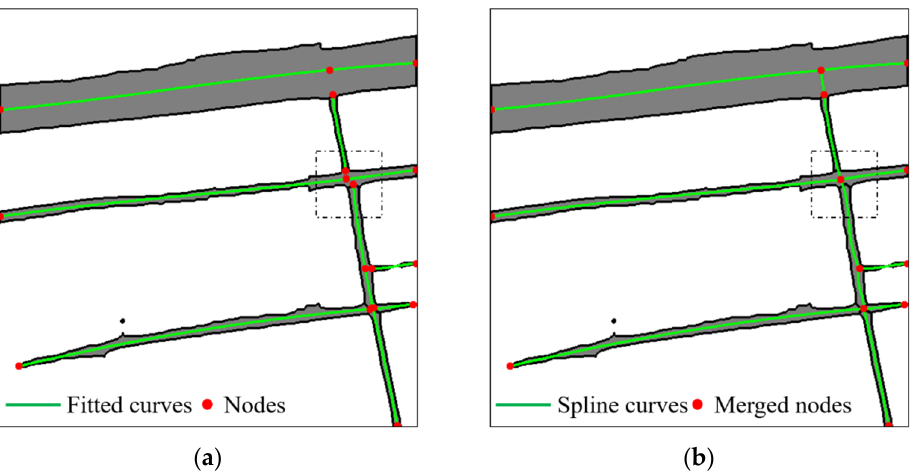
Figure 8. An example for spline fitting. ( a ) Fitted polynomial curves and detected nodes on each cluster. ( b ) Spline fitting based on merged nodes.